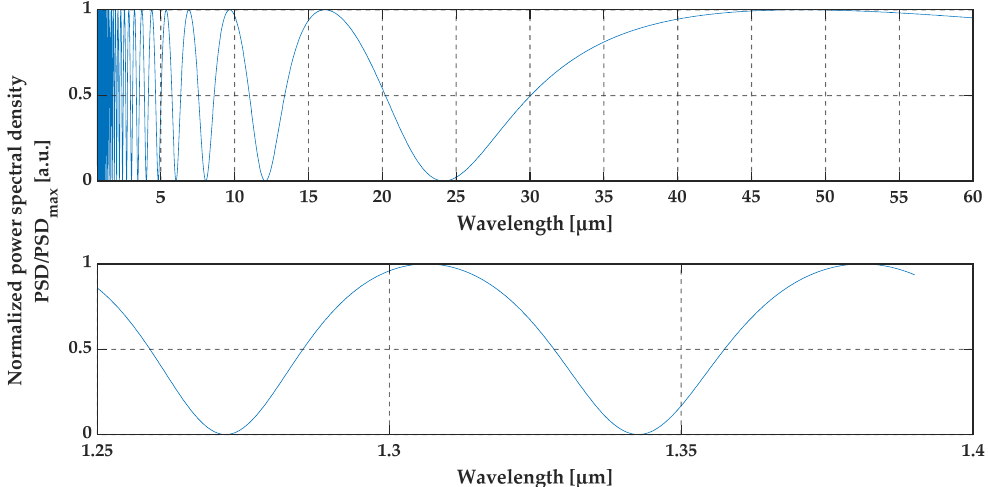
Figure 3. Interference signal obtained from a Fabry–Pérot etalon. A thin foil of diamond with a thickness of 5 µm was used as a cavity. Both plots present the spectral characteristics of the optical radiation (with a uniform spectral distribution) from the Fabry–Pérot etalon.